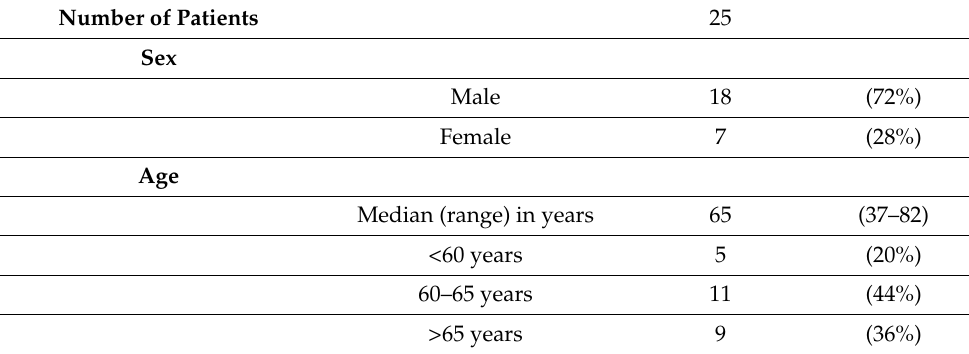
Table 1. Patients and tumor